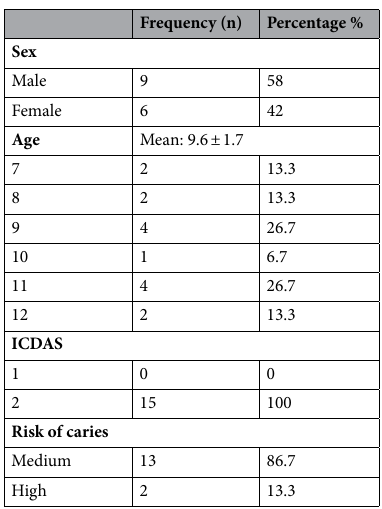
Table 3. Characteristics of the population that donated the dental